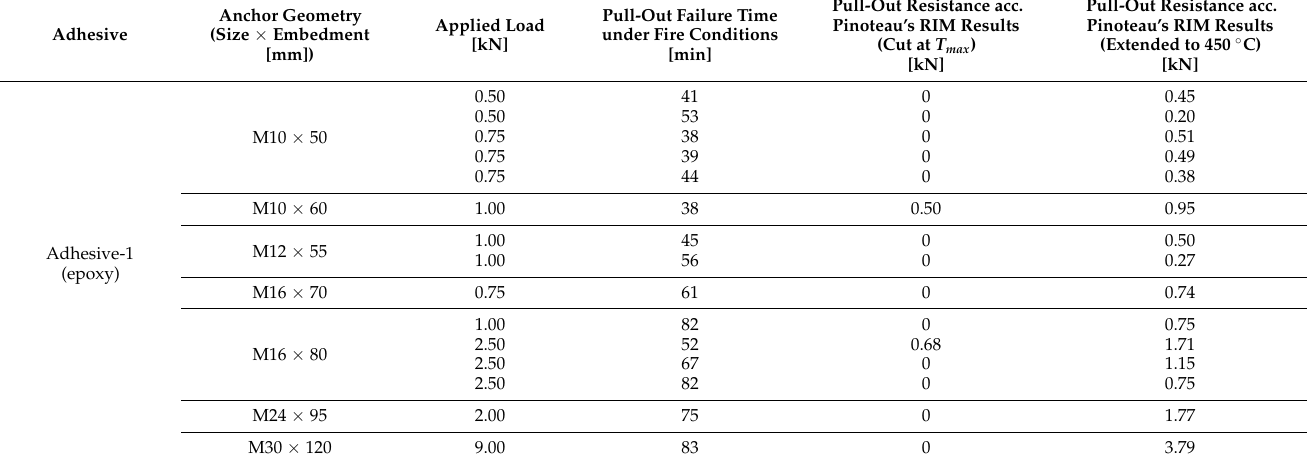
Table 1. Summary of the data of the study (fire tests and simulation results).